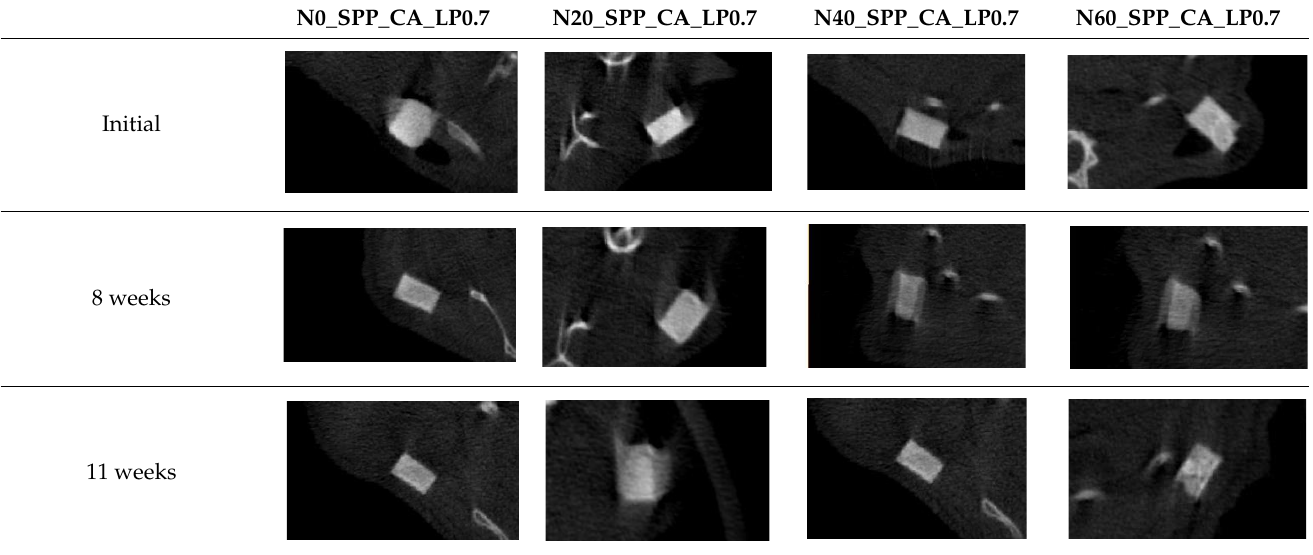
Table 7. Examples of X-ray micrographs for ceramics with SPP_CA and X-ray density (HU) of the implants immediately after implantation (initial), after 8 weeks, and after 11 weeks in situ.